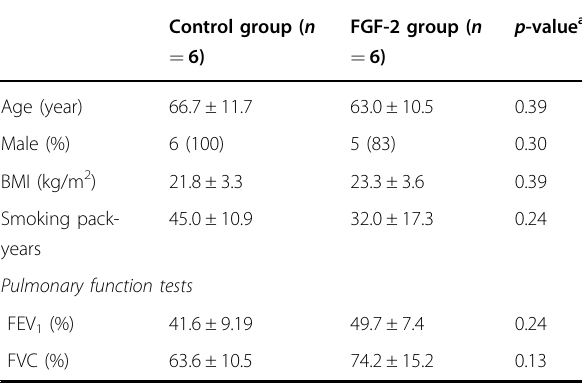
Table 1 Demographic characteristics of the subjects in the clinical